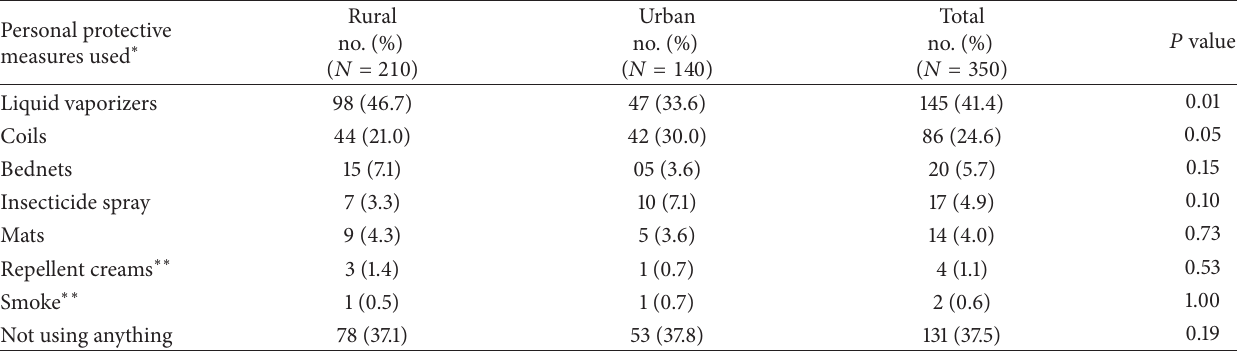
Table 2: Areawise distribution of practices about personal protective measures.